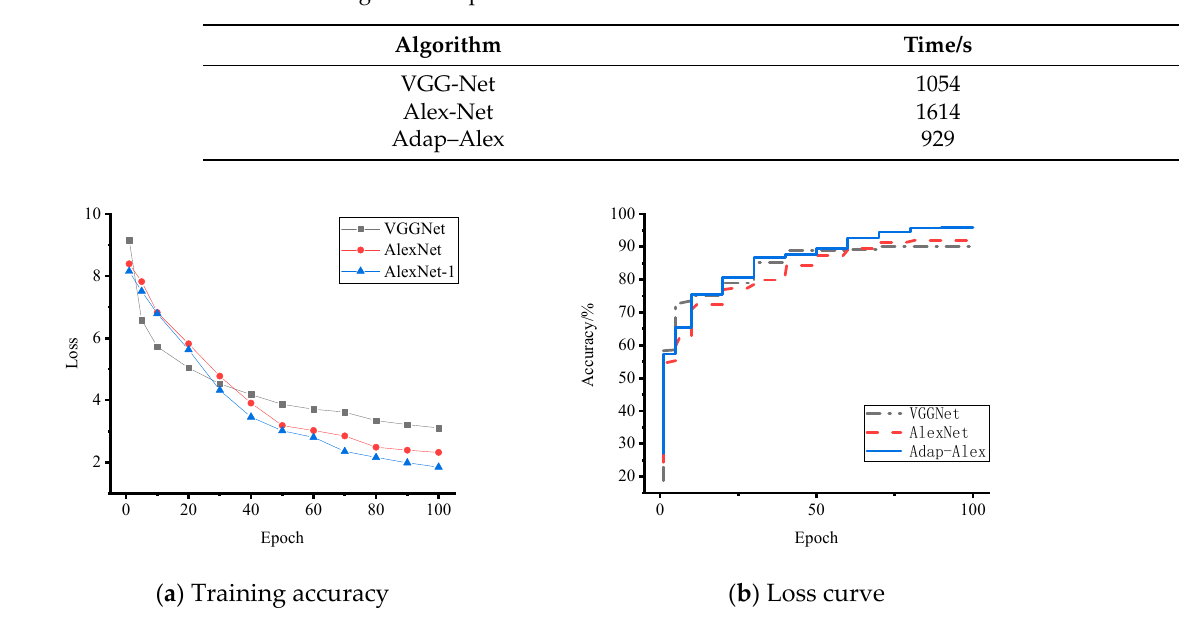
Table 6. Training time comparison.